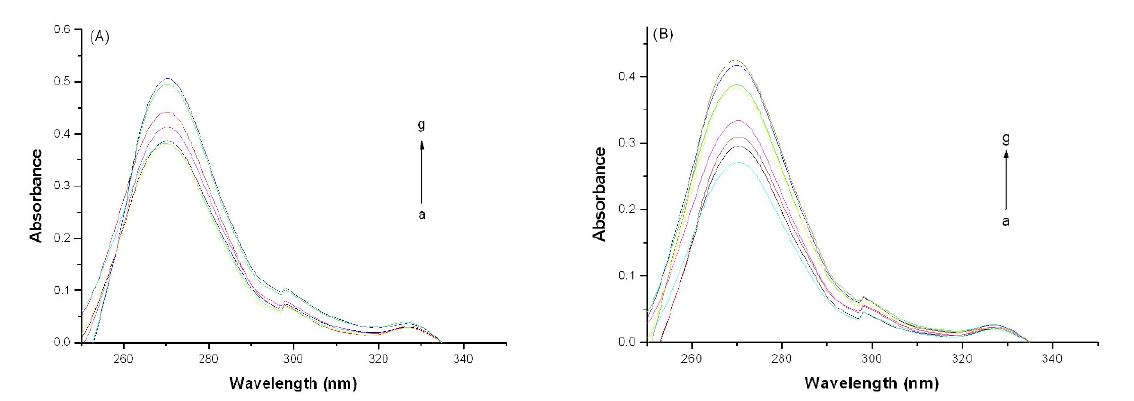
Figure 3. Electronic spectra of karanjachromene (2.3×10 -5 M) in the absence (a) and the presence of 1 µM (b), 10 µM (c), 12 µM (d), 20 µM (e), 25 µM (f), 30 µM (g) DNA at pH 7.4 (A) and 4.7 (B) and at 37ºC. The direction of arrow indicates addition of DNA concentrations. Table 1. Binding constants and free energy values for the flavonoids–ds.DNA complexes at physiological conditions. Complex